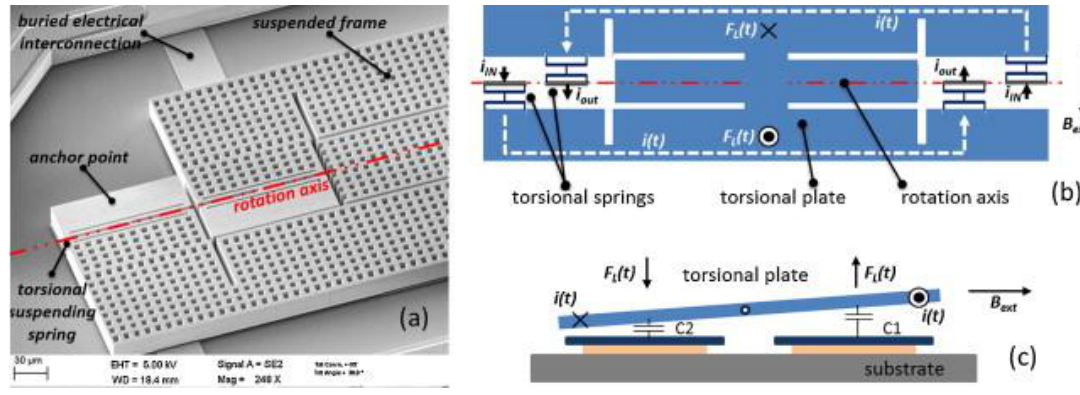
Figure 26. ( a ) SEM image of a MEMS magnetic field sensor with capacitive sensing for IMUs applications; ( b ) Top view; and ( c ) cross-section of the operating principle of the sensor [46]. Reprinted with permission from [46]. Copyright© 2015, Elsevier B. V.